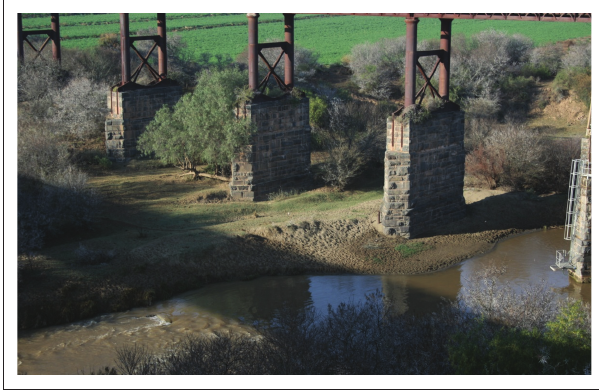
FIGURE 7: The Great Fish River on R67 towards Fort Beaufort in the Cacadu